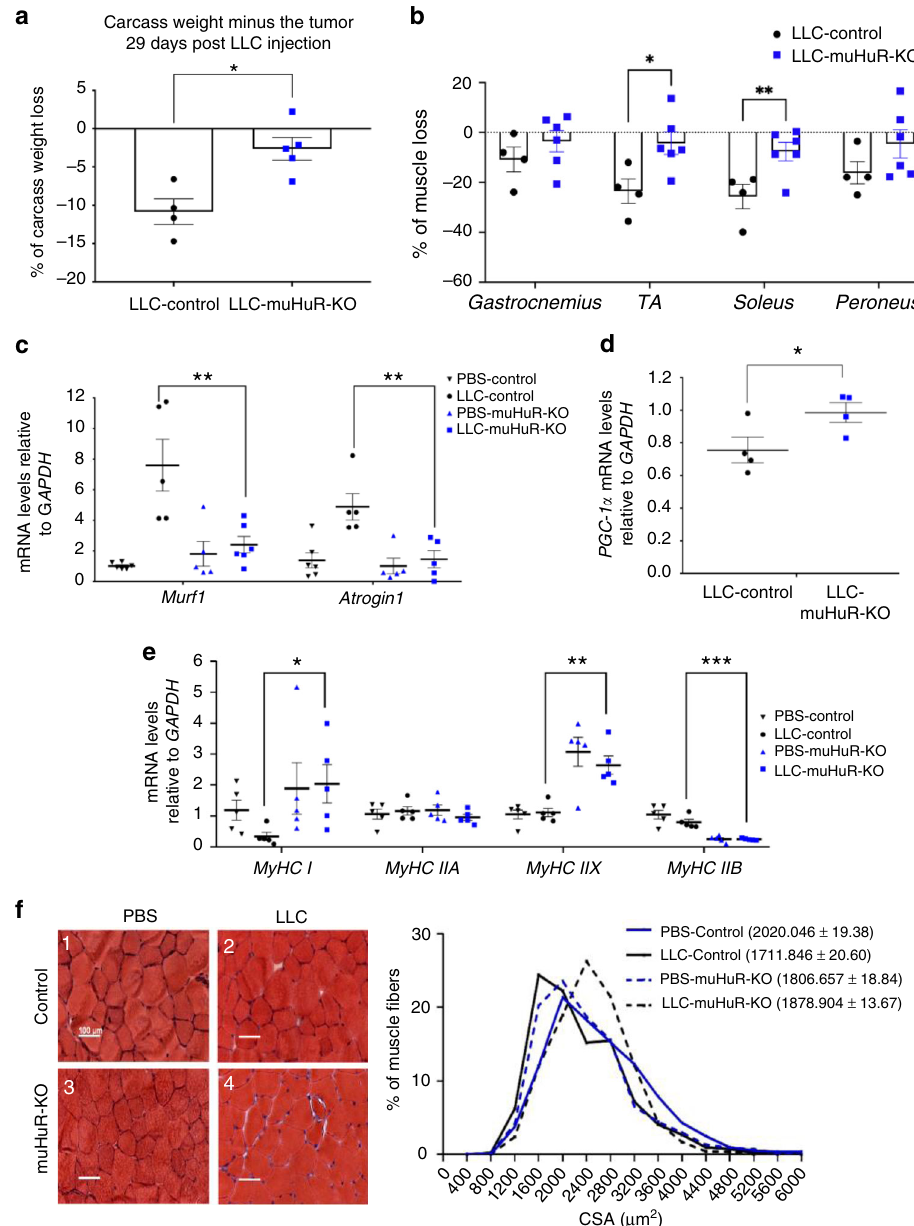
Fig. 8 HuR ablation in skeletal muscle ameliorates cancer-induced muscle wasting. Muscle atrophy was evaluated in Ctl and muHuR-KO mice using the LLC model of cachexia. a Catabolic wasting was assessed post-mortem on tumor-bearing LLC-Ctl and -muHuR-KO mice by measuring total body weight minus tumor weight. The results are presented as mean ± S.E.M * p < 0.05 unpaired t -test, (LLC-Control n = 4, LLC-muHuR-KO n = 5). b Muscle atrophy was assessed by determining the relative loss of muscle mass in gastrocnemius , TA, soleus , and peroneus muscles from LLC-Control and LLC-muHuR-KO mice. Percentage (%) of muscle loss in both groups is shown relative to non-tumor PBS injected mice from each cohort (LLC-Control n = 4 and LLC-HuR- KO n = 6). c – e Total RNA was isolated from the gastrocnemius muscle of control and muHuR-KO mice bearing or not LLC tumors. Relative mRNA expression levels of Atrogin1 and MuRF1 ( c ) , PGC-1 α ( d ), MyHC I, MyHC IIA, MyHC IIB, and MyHC IIX ( e ) was ass e ssed by RT-qPCR and mRNA expression levels was determined relative to GAPDH transcript. Expression levels are shown as the fold of induction relative to control-PBS treated mice. ( d , n = 4), ( c , e , n = 5). f Left panel: representative photomicrographs of gastrocnemius muscles sections from control and muHuR-KO mice taken after H&E staining. Scale bars = 100 μ m. Right panel: frequency histogram showing the distribution of muscle fi ber CSA in the gastrocnemius muscles from control and muHuR- KO mice bearing or not LLC tumors ( n = 4 mice per group). A total of 500 fi ber per muscle were used for the CSA analysis. The results are presented as mean ± S.E.M, * p < 0.05, ** p < 0.005, *** p < 0.0005 unpaired t -test. Source Data for a , b , c , d , e , and f (right) panels are provided in the Source Data